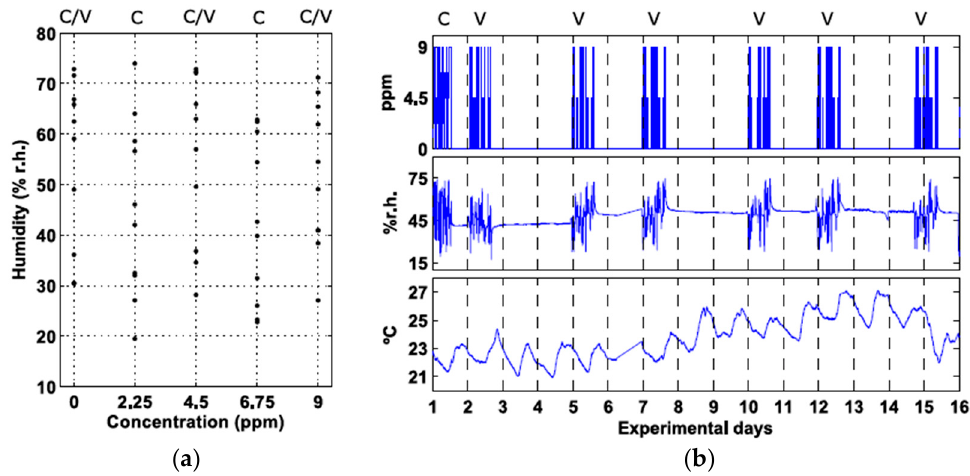
Figure 3. Experimental design. ( a ) Carbon monoxide and humidity values presented to the sensors in calibration and validation. “C” stands for Calibration and “V” for Validation. “C/V” means that the condition was used for both calibration and validation; ( b ) Validation plan. The subplots represent (from top to bottom) the CO concentration (ppm), the measured humidity (% relative humidity (r.h.)), and the measured temperature (°C).